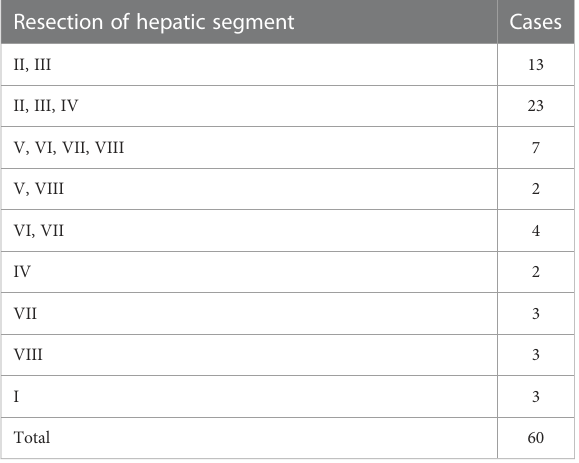
TABLE 1 Laparoscopic hepatectomy via hepatic vein approach(60